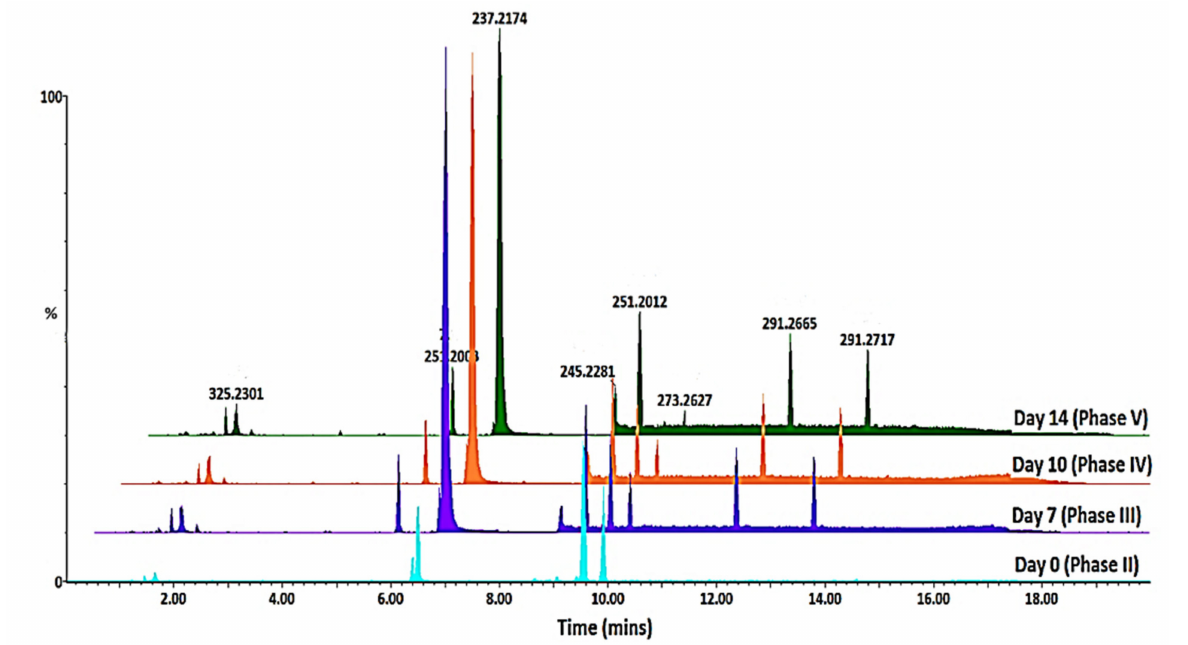
Figure 3. Representation of the ultra-high performance liquid chromatography separation with high-definition mass spectrometry detection of DMSO-/methanolic extracts of sclareol-treated H. roseoniger . The cells were harvested from selected days over a 15 d growth period (phases II–V). The representative base peak intensity (BPI) MS chromatograms were acquired in ESI+ mode and show evident differences in peak intensities and presence/absence across the different phases. The chro- matograms were offset by 0.5 min increments on the retention time scale ( x -axis) and the y -axes were linked to allow for the comparison of relative peak intensities, expressed as percentages. Retention times and m / z values: sclareol/epi-sclareol: (9.54/10.00 min, m / z 273.2574), ambradiol: (6.51 min, m / z 237.2162), sclareolide I/II: (5.63/9.10, m / z 251.1988), abienol: (11.86/13.28, m / z